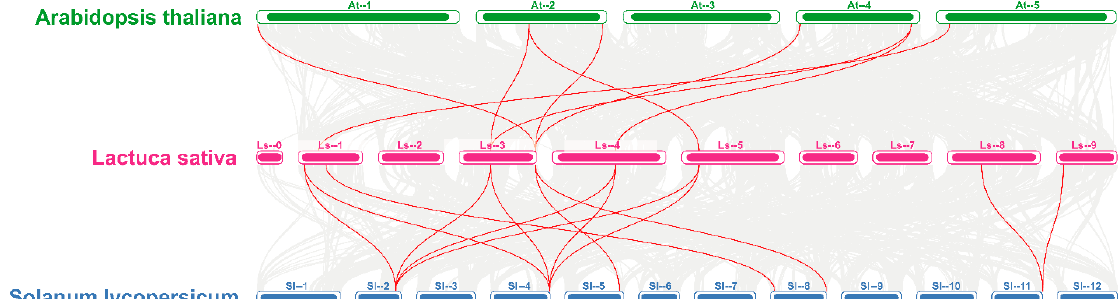
Figure 6. Collinearity analysis of lettuce with Arabidopsis and tomato. The gray line in the background represents all collinear pairs of lettuce with Arabidopsis and tomato at the genomic level. The red line represents the collinear pairs belonging to MAPK family members from those three species.